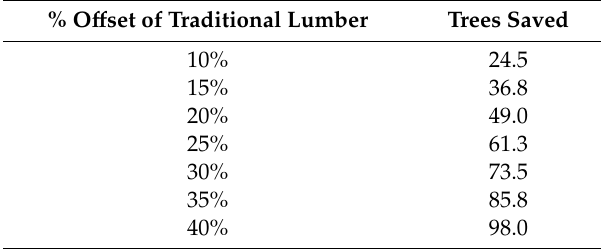
Table 2. Estimate of trees saved by using engineered lumber (finger-jointed studs) in this case study. % O ff set of Traditional